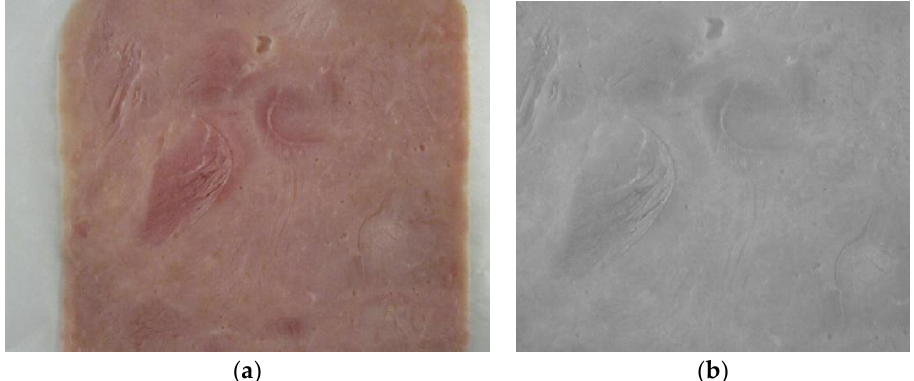
Figure 1. ( a ) Digital image of boiled-pork slice, and ( b ) grayscale sample used in textural-feature calculation.